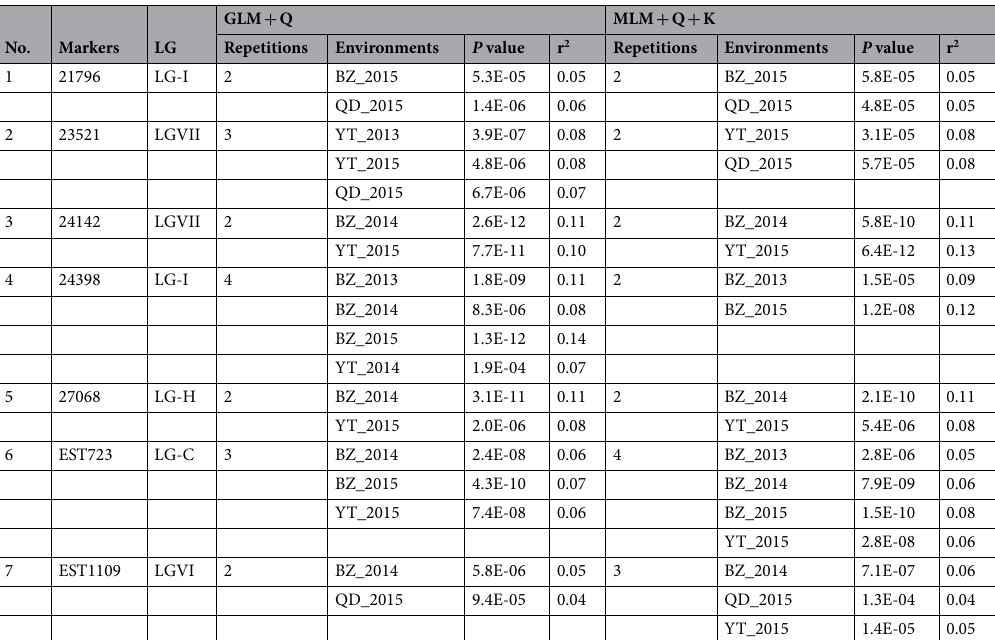
Table 3. Summary of significant marker-trait associations for frost tolerance repeatedly detected in different experiments with two